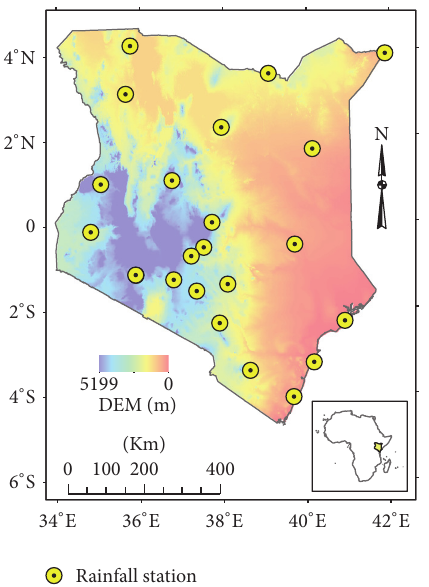
00 Figure 1: Locations of the meteorological stations in Kenya (see Table 1 for details). The background map is the Digital Elevation Model (DEM) downloaded from the International Centre for Trop- ical Agriculture, CIAT-CSI SRTM website,